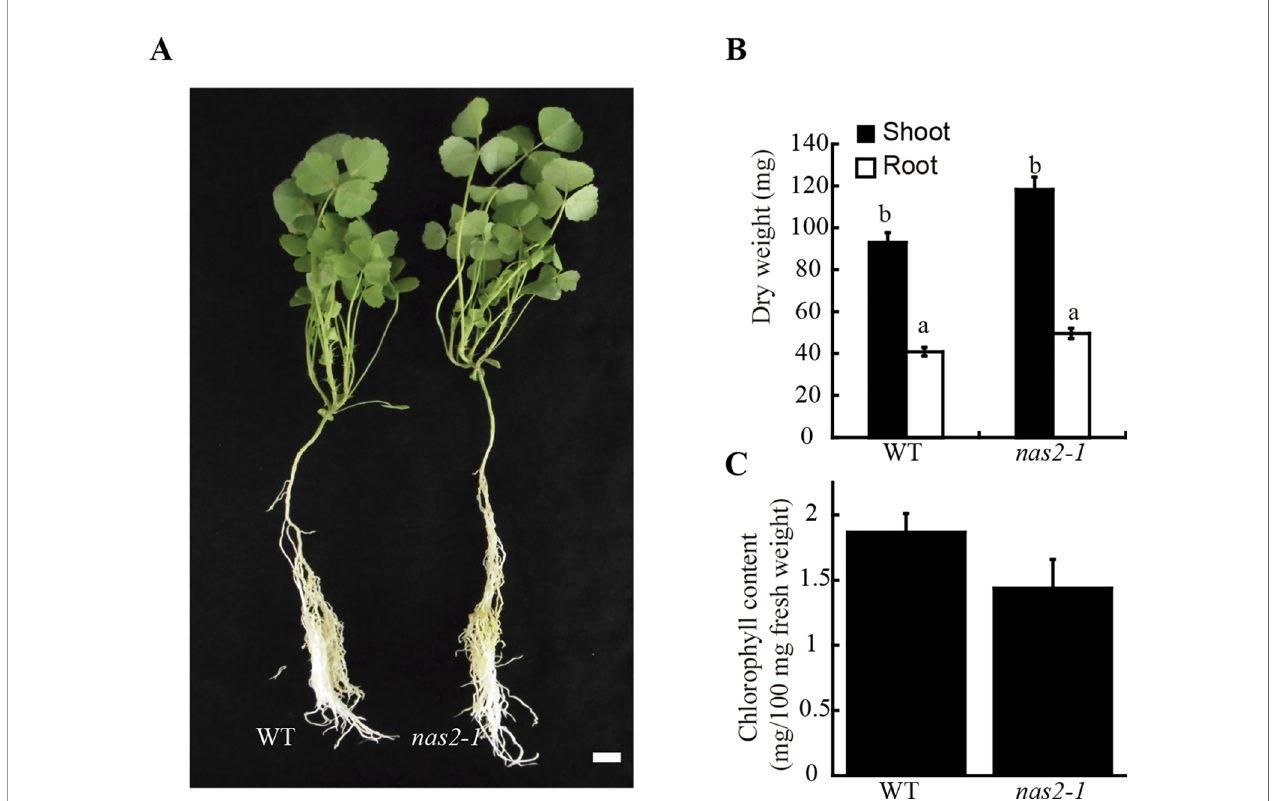
FIGURE 3 | MtNAS2 is not required for plant growth under non-symbiotic conditions. (A) Growth of representative wild-type (WT) and nas2-1 plants when watered with a nutrient solution supplemented with ammonium nitrate and not inoculated with Sinorhizobium meliloti (n = 10 – 15 plants). Bar = 1.5 cm. (B) Dry weight of WT and nas2-1 plants. Data are the mean ± SE (n = 10 plants). Different letters indicate statistical differences at P < 0.05 (Tukey t-test). (C) Chlorophyll concentration of wild-type and nas2-1 plants. Data are the mean ± SE of three sets of fi ve pooled plants. No differences at P < 0.05 were observed (Student